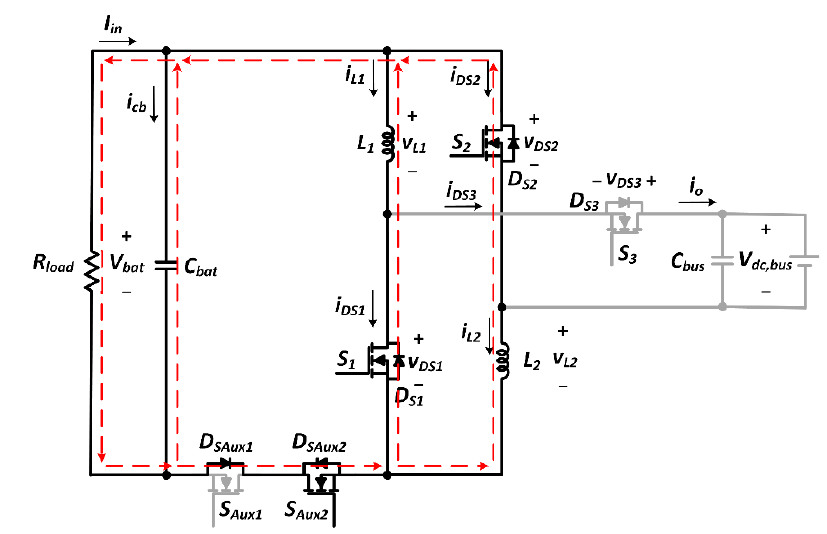
Figure 8. The current flow paths of step-down mode ii .